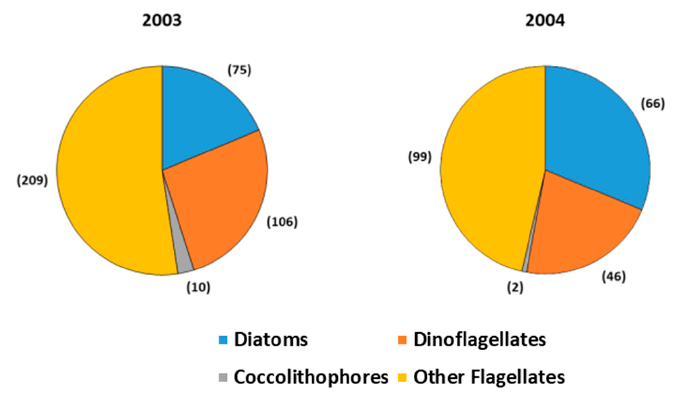
Figure 2. The mean phytoplankton composition (cells 10 4 L − 1 ) during early March 2003 and 2004 in Thermaikos Gulf. Table 2. The mean water column values of A. clausi parameters over the sampling period (mean ± SE).